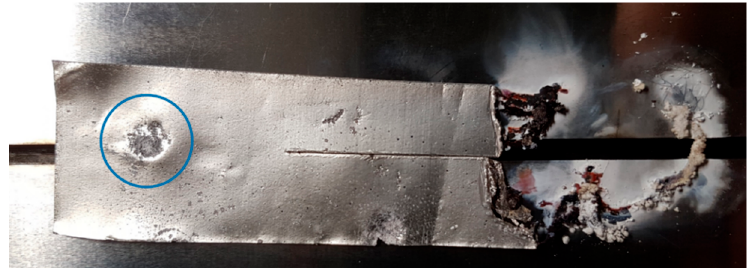
Figure 18. Image of lithium metal fire initiated by Laser lithium hydroxide interaction (blue circle); Lithium metal after 1.5 years at a dew point of − 30 °C; 72.8 W, 490 kHz, 240 ns, dew point − 30 °C; 50 Lithium metal after 1.5 years at a dew point of − 30 ◦ C; 72.8 W, 490 kHz, 240 ns, dew point − 30 ◦ C; mm/s, PO 99.89%. 50 mm/s, PO